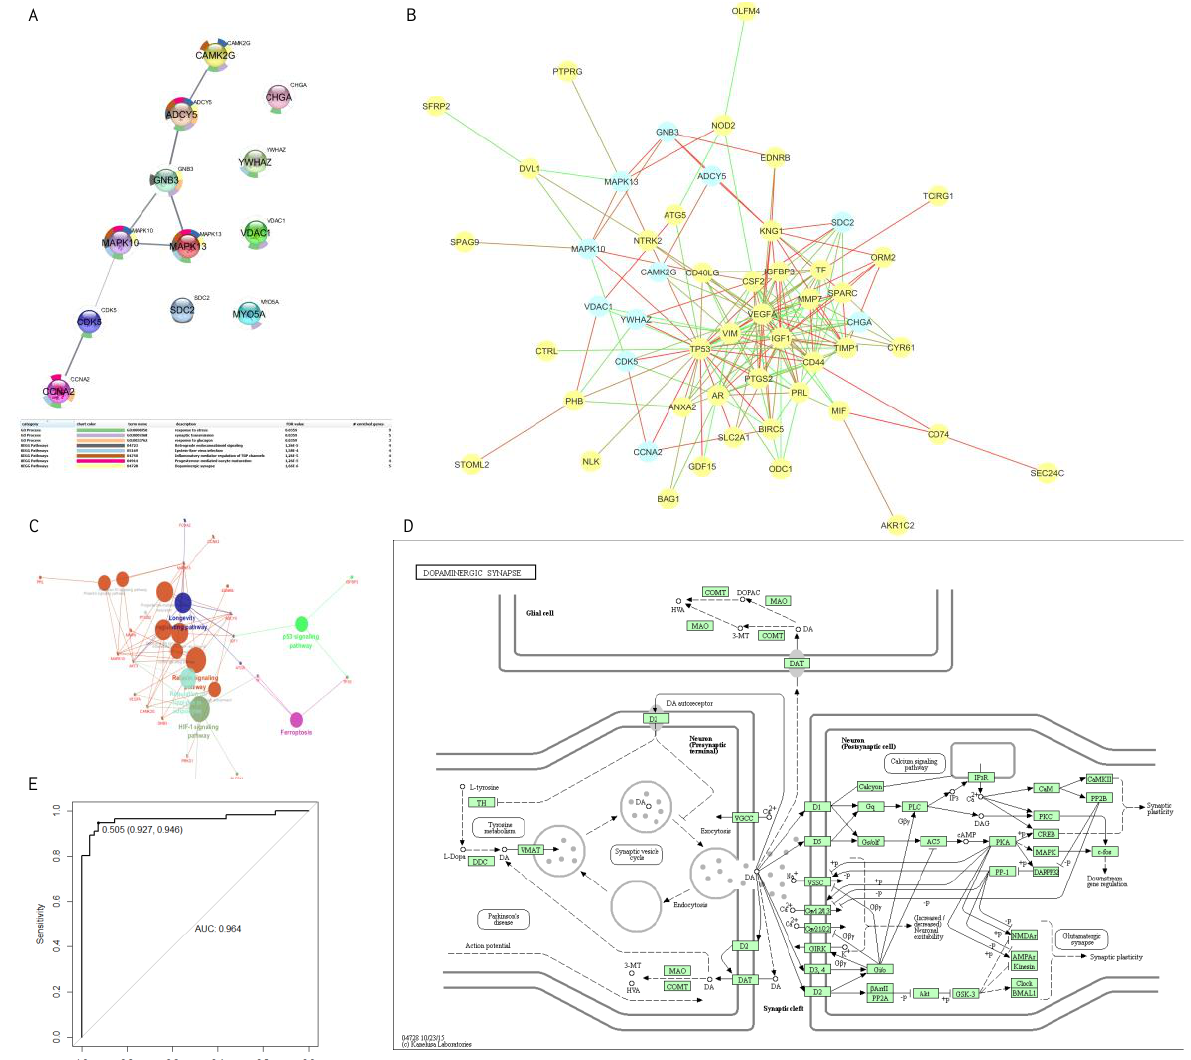
Figure 3. PPI network and biological function analysis of the predicted biomarkers. ( A ) PPI rela- tionships and enriched pathways (table) for the 12 predicted biomarkers. A total of seven predicted biomarkers related to each other. In addition, nine predicted biomarkers were mapped on the re- sponse to stress pathway. The candidate biomarkers that had a strong relationship were mapped in the same pathway. ( B ) PPI network for predicted and confirmed biomarkers. The color of lines represented the confidence of connected evidence: the closer to red, the higher evidence. Generally, the predicted and confirmed biomarkers had strong relationships with each other; specifically, not as the other ten predicted, which are connected closely, CHGA and SDC2 were separated from them and were hubs in their belonged small networks. ( C ) KEGG pathway enrichment analysis results for predicted and confirmed biomarkers. Big circles represent enriched pathways, and small circles/diamonds represent confirmed/predicted biomarkers. Pathways and biomarkers were con- nected if the biomarkers were mapped on the pathways. There were some overlapping pathways among the confirmed and predicted biomarkers, and five of them were mapped on the Dopaminergic synapse pathway. ( D ) Dopaminergic synapse pathway. ( E ) Diagnostic ROC curve for multiple biomarkers combined by the 12 predicted biomarkers, which showed an AUC of